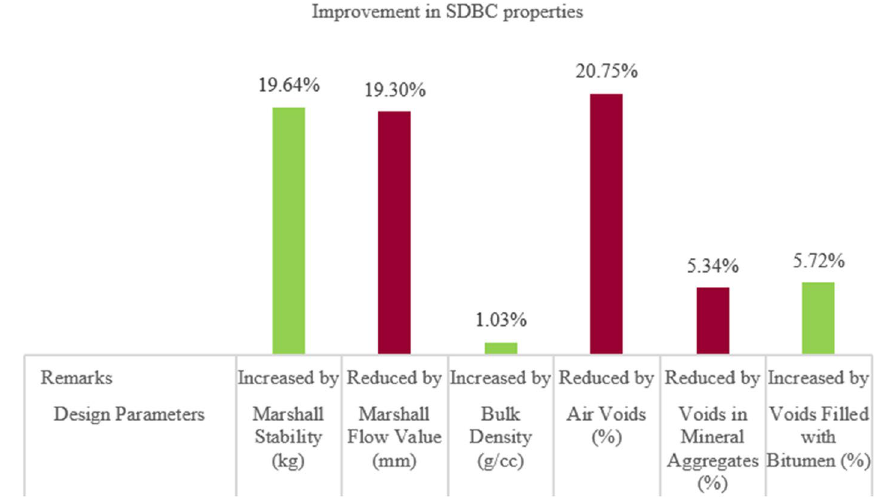
Fig. 30 Enhancement in the properties of modified